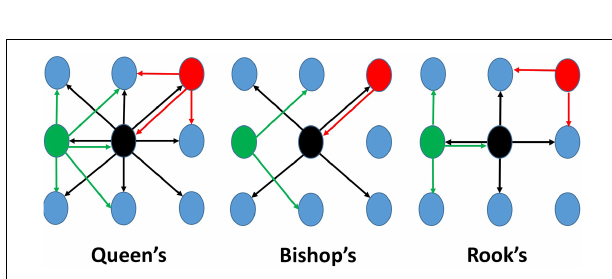
FIGURE 2 | Three examples of contiguity weighting schemes for generating weighting matrices. “Queen’s case” ( left ) was used in this study, while “Bishop’s case” is in the middle, and “Rook’s case” is on the right. Colored arrows indicate which hydrophones would be considered an adjacent neighbor to the same colored hydrophone. Notice: not all hydrophones will have the same number of